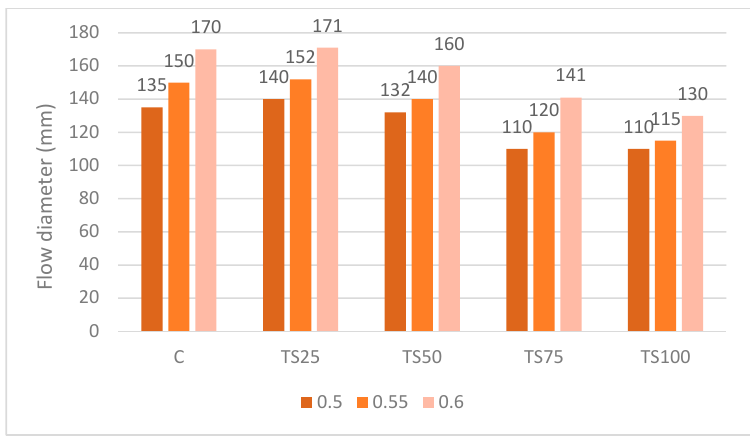
Figure 6. Mortar consistencies: ( a ) normal flow and ( b ) scattered flow.